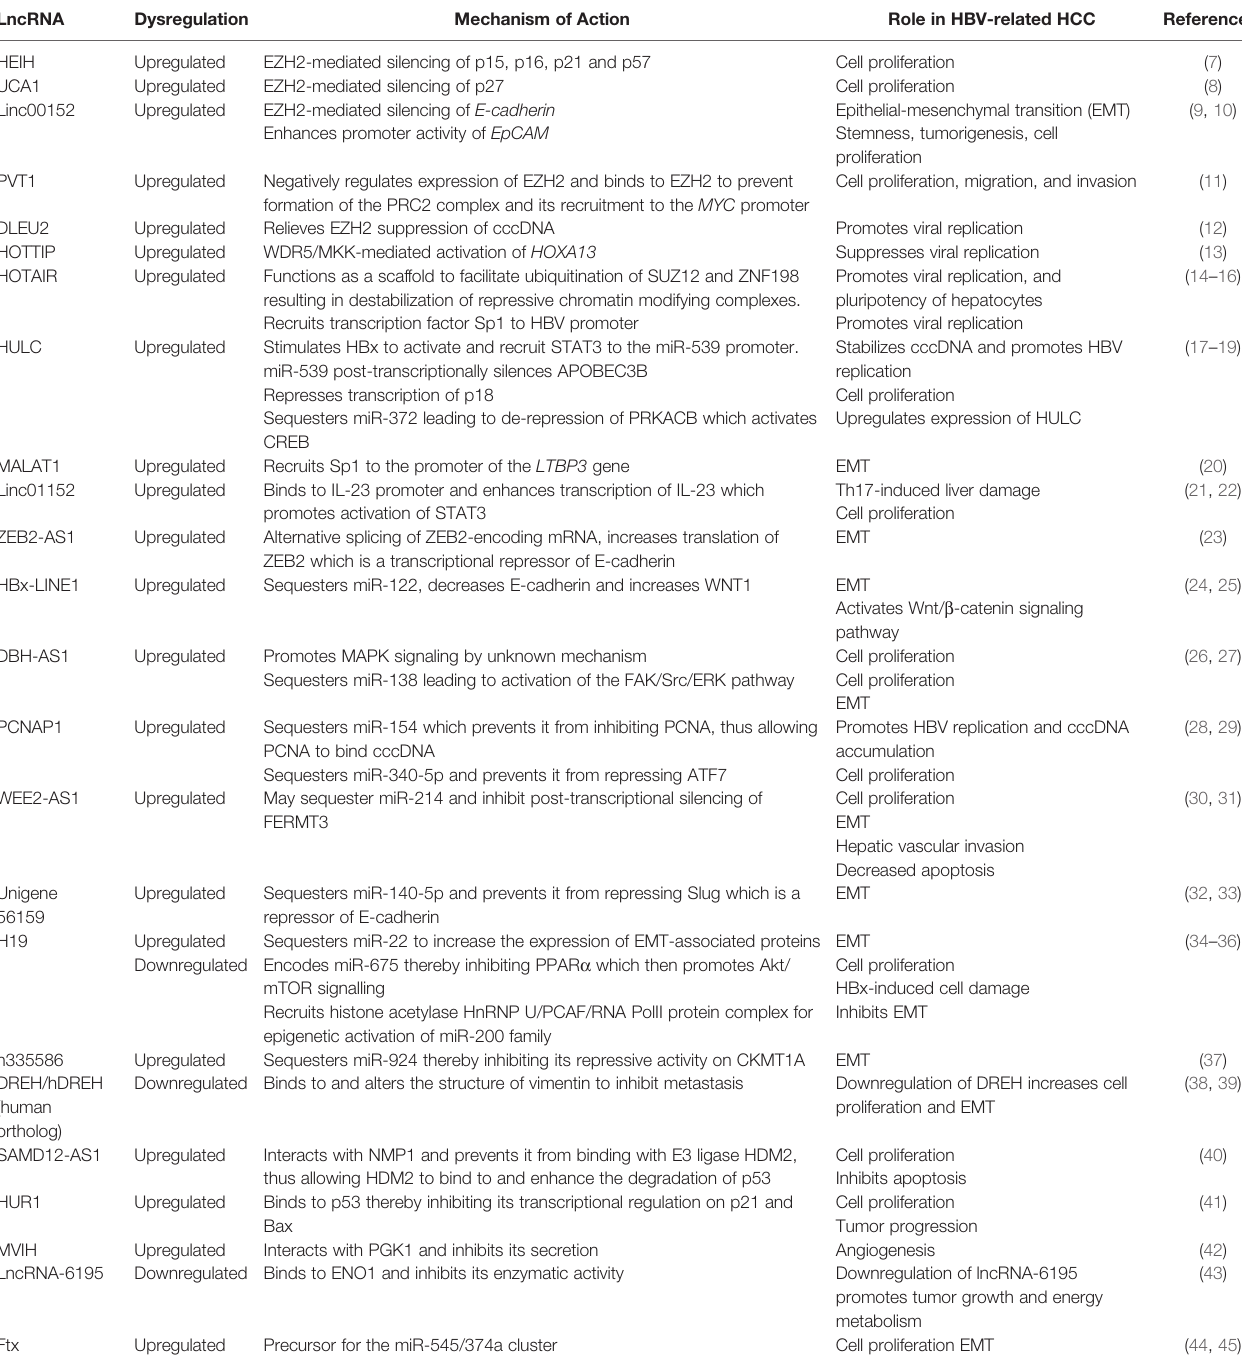
TABLE 1 | LncRNAs dysregulated in HBV-related HCC and their functions.